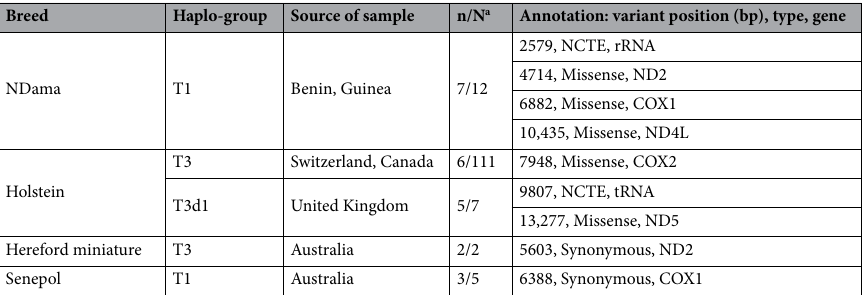
Table 5. Breeds found to have specific private (one breed only) mitogenome variants with annotation of the variants (position, type and genes affected) and number of animals sharing the private variants within each breed. a N = total number of animals in a breed in the sub-haplogroup; n = number of animals with private variants in a breed within the haplogroup; NCTE = non-coding transcript exon.